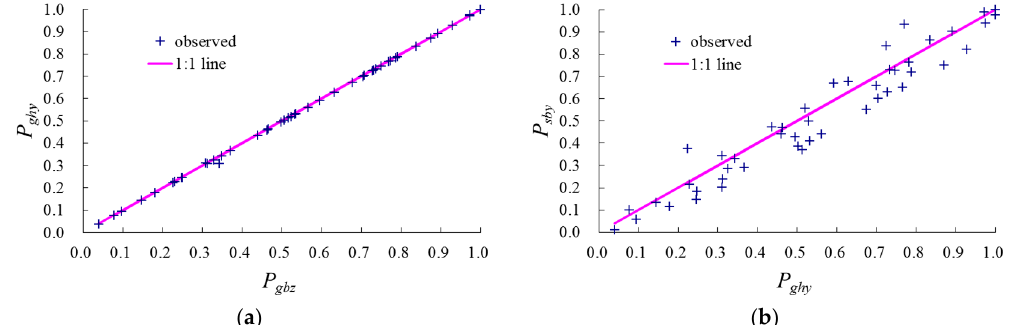
Figure 6. Occurrence probability of equivalent frequency floods for sub-basin and downstream site. Note: P sby , P ghy , and P gbz represent the exceedance probability of three-day flood volume for Shuibuya, Geheyan and Gaobazhou reservoir site, respectively. The straight lines show the conditions when exceedance probability of three-day flood volume for Geheyan and Gaobazhou, Shuibuya and Geheyan are identical, respectively. ( a ) Geheyan and Gaobazhou reservoir sites; and ( b ) Shuibuya and Geheyan reservoir sites.